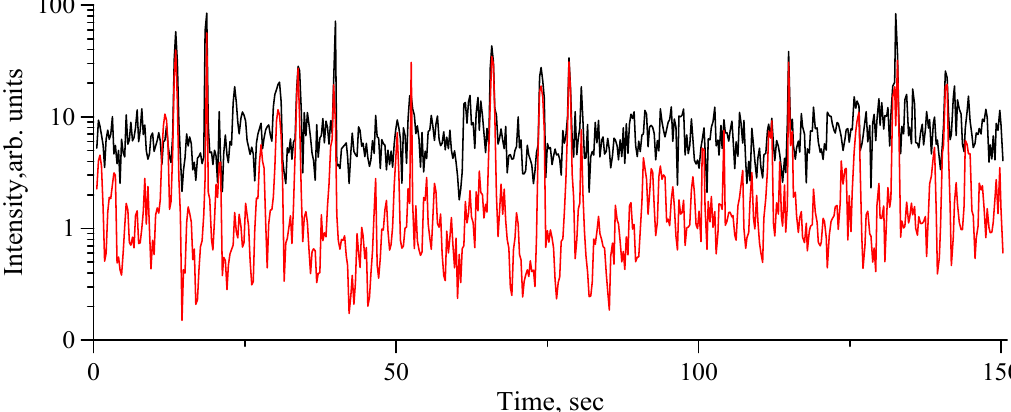
Figure 5. Record of radar return at VV (black curve) and HH (red curve) polarizations; wind velocity of 10 m/s, incidence angle of 55 degrees.